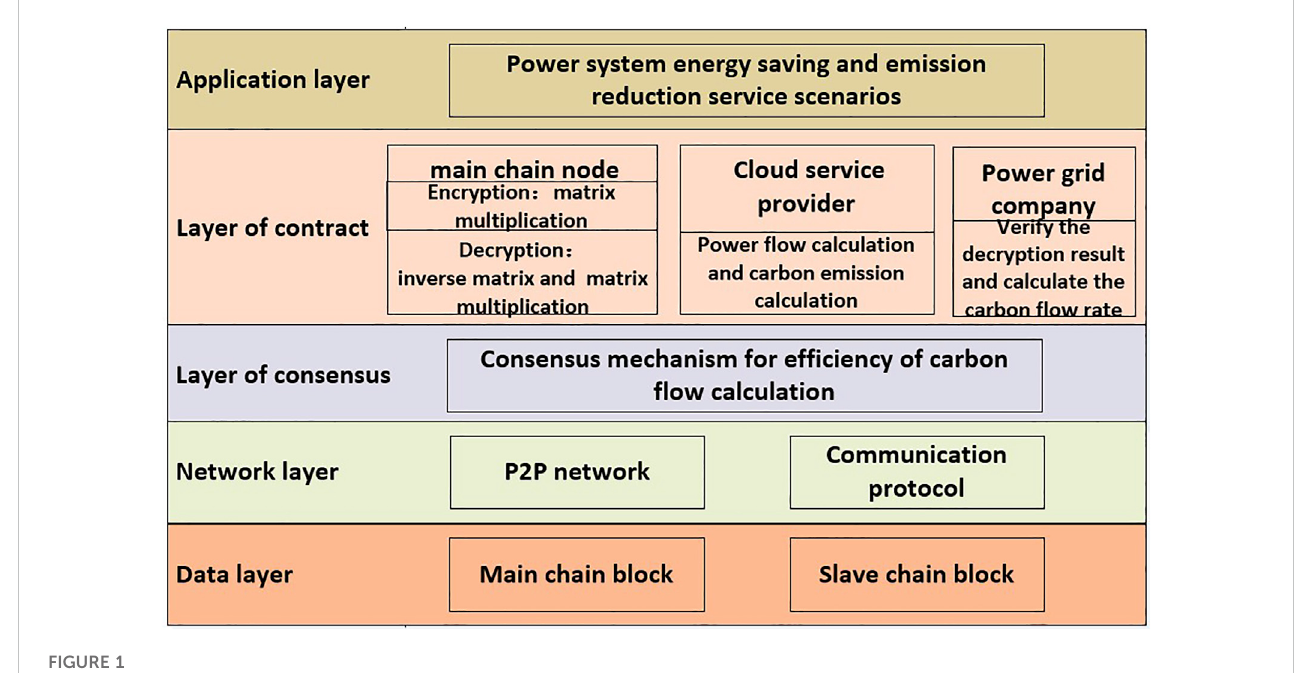
FIGURE 1 Carbon fl ow tracing